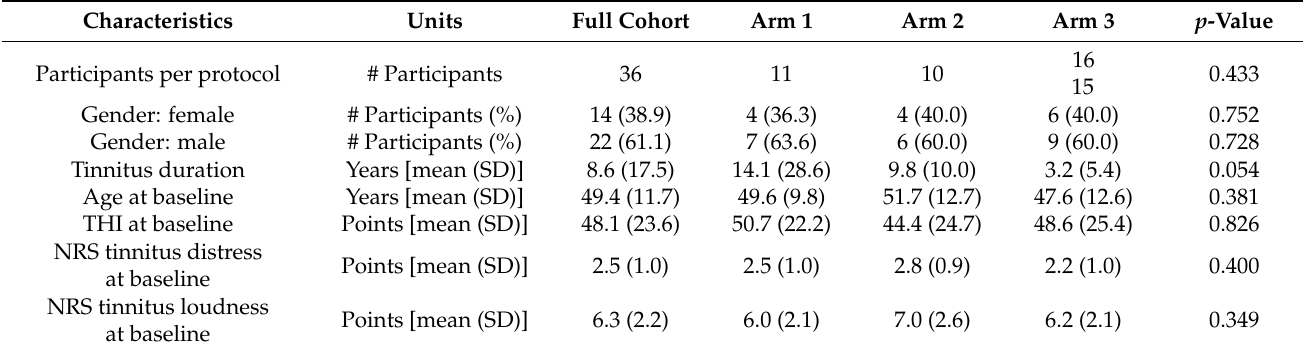
Table 1. Characteristics of participants in final analysis. p values is based on Chi square test for count variables or Kruskal–Wallis test for continuous variables. The sum scores of the THI range from 0 to 100. The scores for NRS the tinnitus distress range from 1 to 5, while the scores for the NRS tinnitus loudness range from 0 to 10.